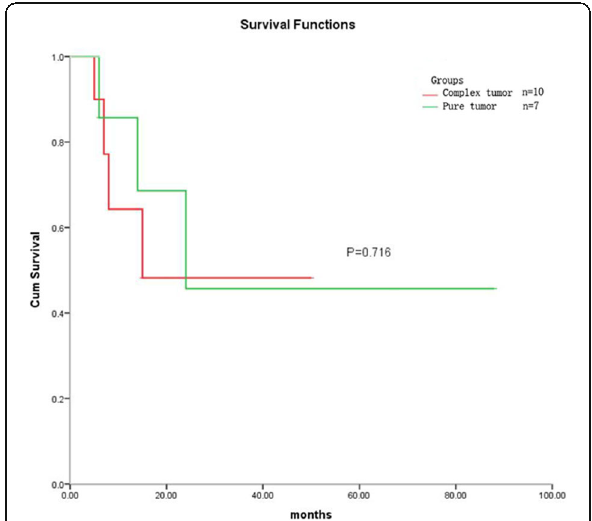
Fig. 2 Survival analysis of 17 patients with follow-up data. The patients with composite cervical tumors had similar prognosis to patients with pure small cell